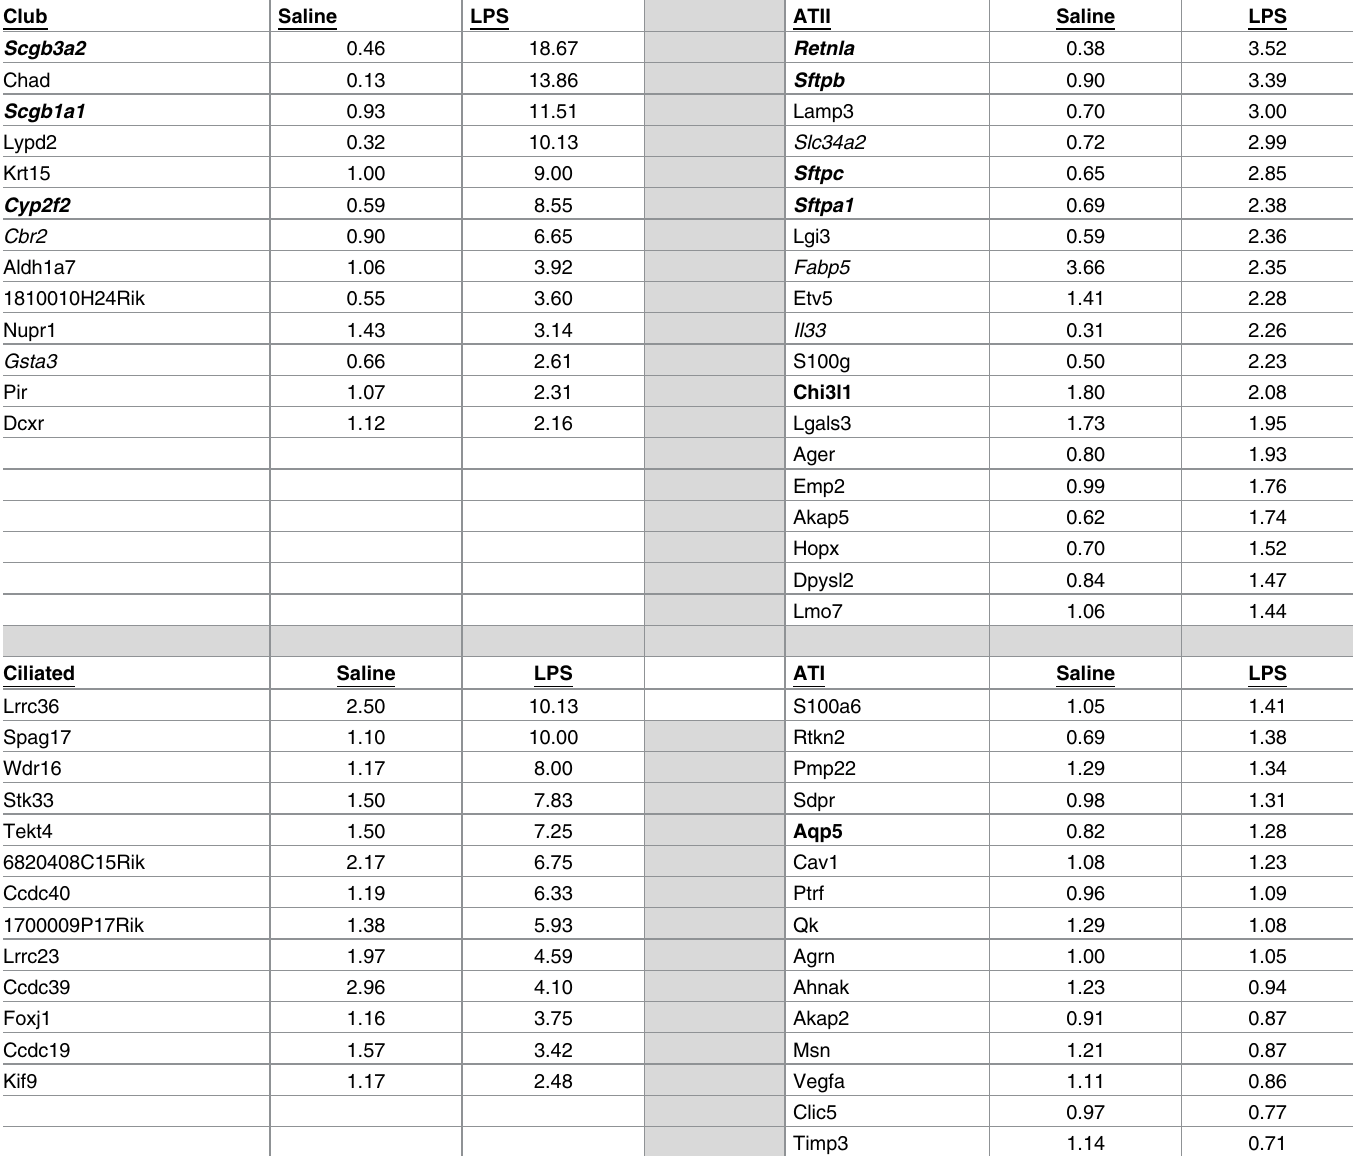
Table 3. Lung epithelium cell-specific transcript expressiondifferences. ( α 7 E260A:G / α 7 G